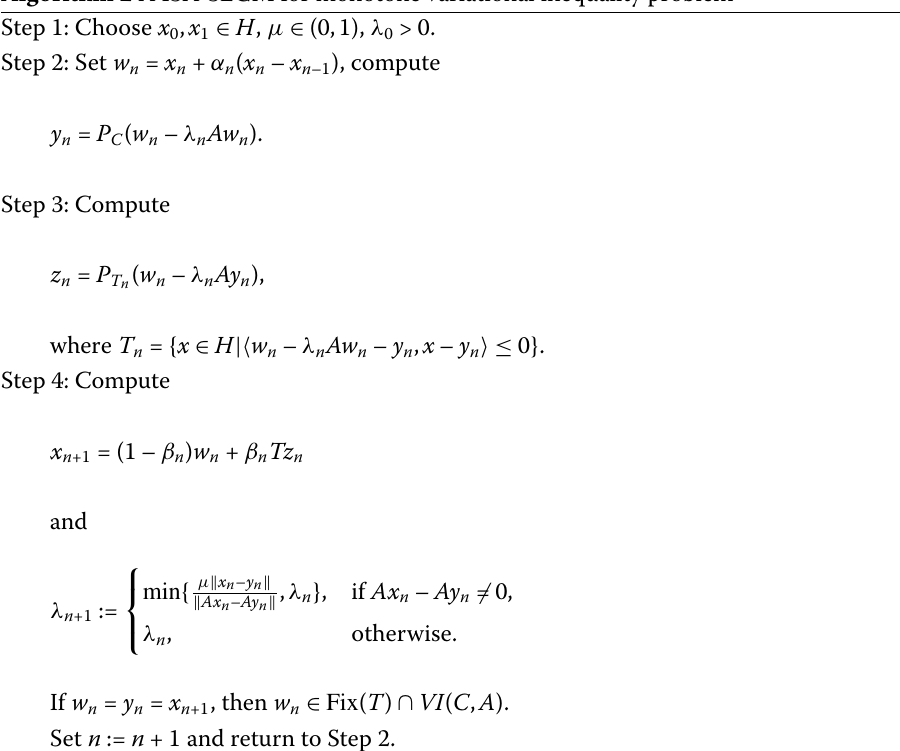
Algorithm 2 A ISA-SEGM for monotone variational inequality